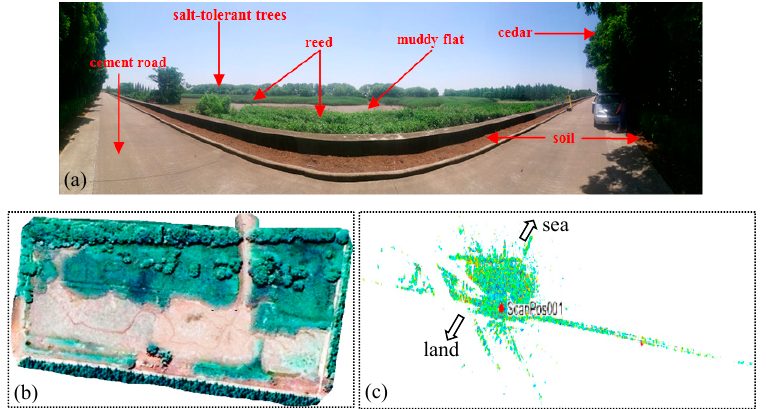
Figure 6. ( a ) Panoramic image of the study site captured by a camera. ( b ) Orthophoto of the study site provided by United States Geological Survey (USGS, https://earthexplorer.usgs.gov/). ( c ) Point clouds of the study site colored by original intensity data in RiSCAN PRO v1.8.1.